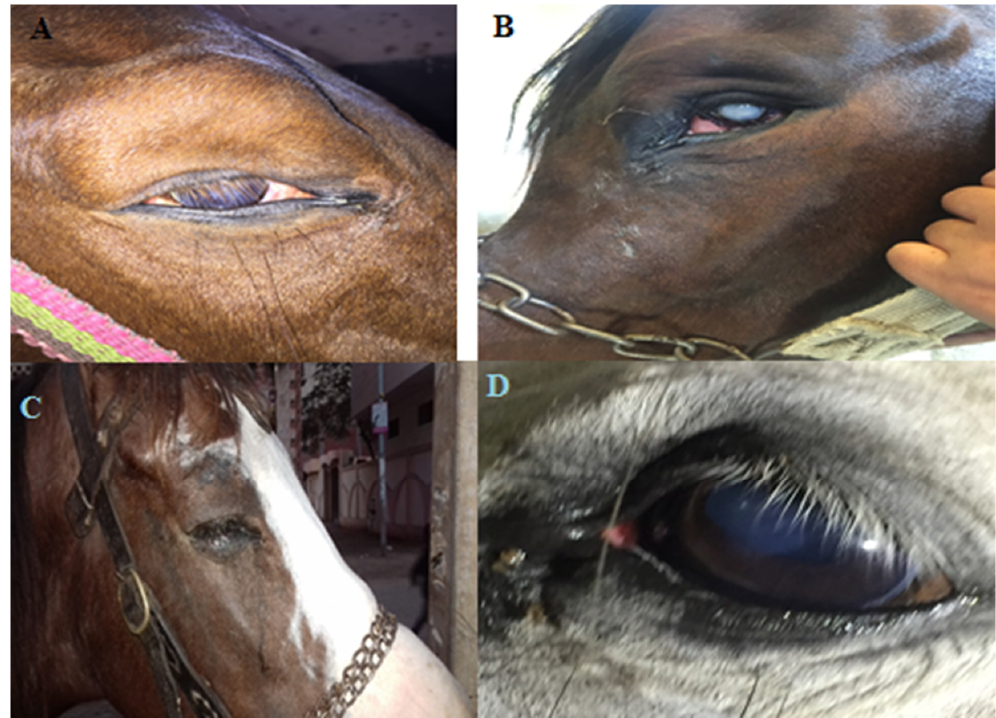
Figure 1. Clinical signs suggest ophthalmic infection. ( A ) A horse with ocular infection showing corneal opacity and mucopurulent discharge. ( B ) A horse’s eye, following exposure to ocular trauma showing corneal opacity. ( C ) A horse suffering from conjunctivitis showing blepharospasm, eyelid edema and continuous lacrimation. ( D ) A donkey showing mucopurulent discharge with eyelid edema.